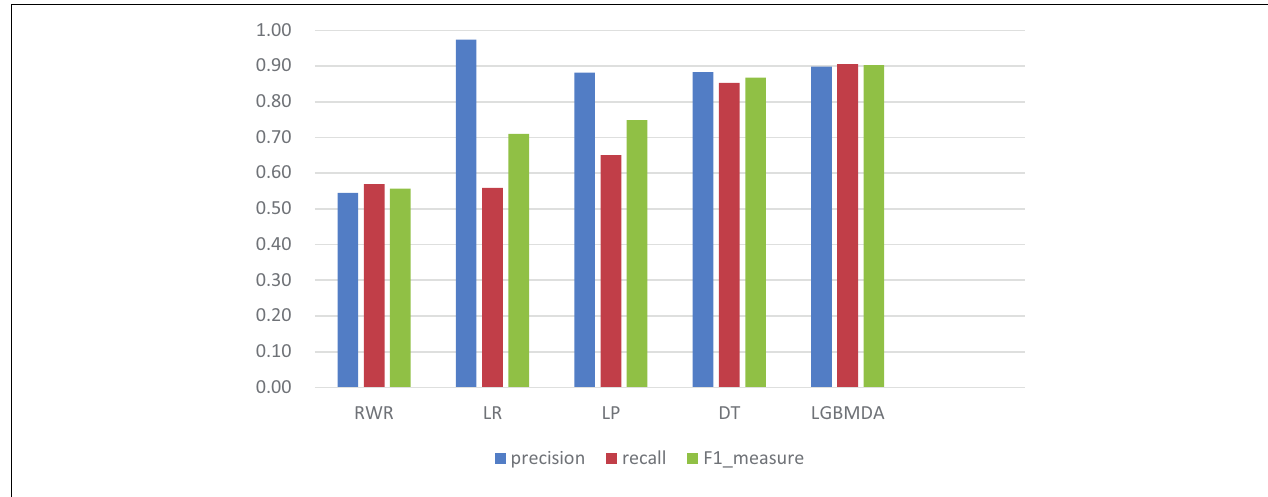
FIGURE 6 | Comparison of the precision, recall, and F1_measure with different methods.